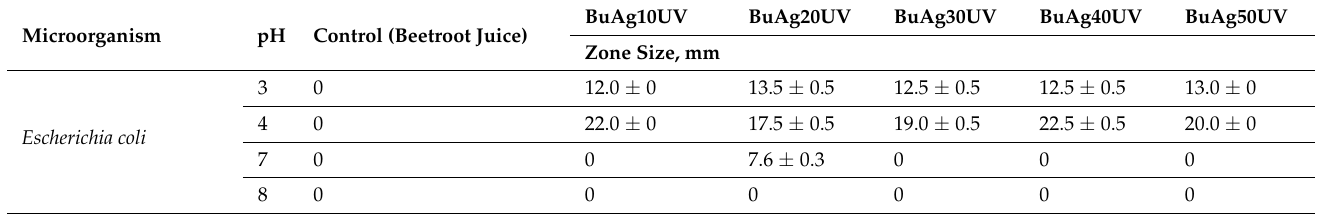
Table 2. Antimicrobial effectiveness of Ag containing samples produced using gelatin solutions with different